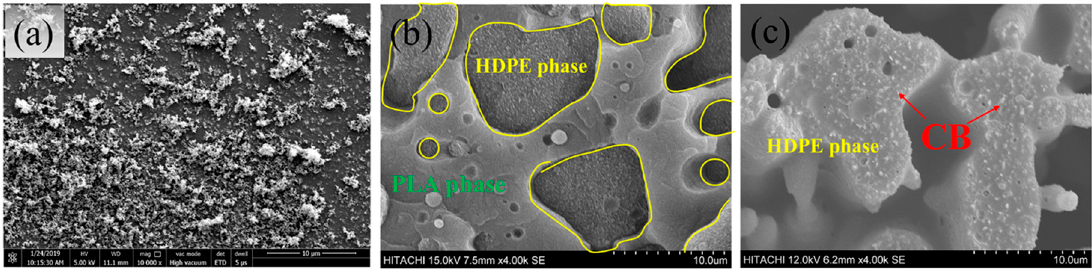
Figure 3. ( a ) SEM of CB, ( b ) SEM of PLA/HDPE/CB (70/30/10) blends, ( c ) SEM of PLA/HDPE/CB (70/30/10) blends etched PLA